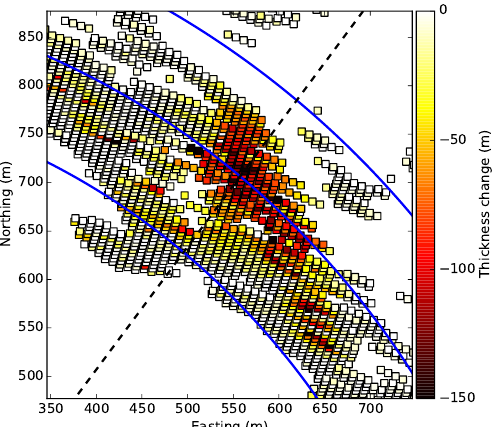
Figure 4. Thickness change during the ice front collapse measured with the TRI. The vertical difference between two DEMs before and after the event (14:06 and 14:07UTC) is shown. Blue circles are in 800, 900, and 1000m distance from the tour boat. The dashed line indicates the location of the profiles shown in Fig.